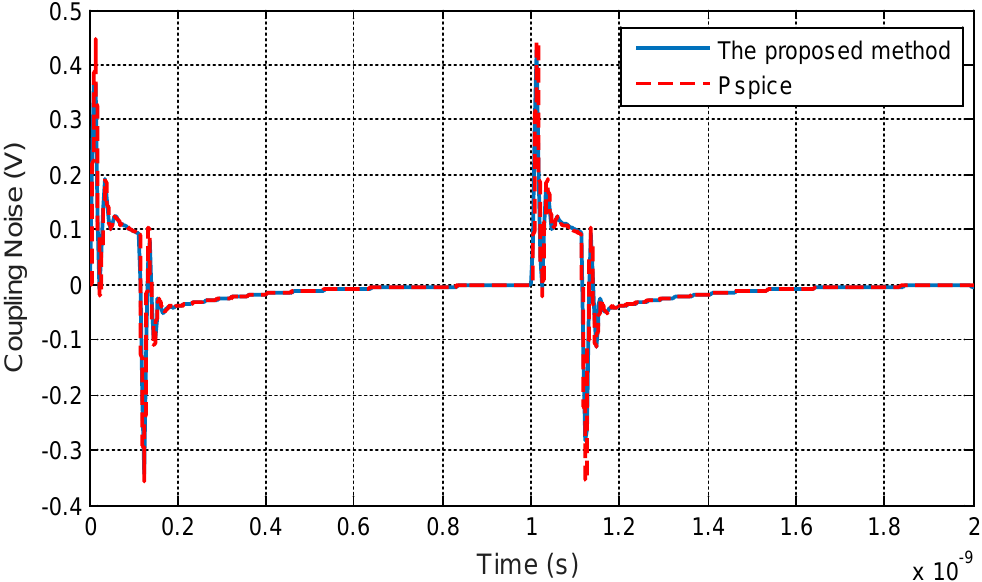
Figure 14. The proposed method and Pspice simulation of the TSV–TSV coupling noise with uncoupled RDLs ( l RDL = 500 µm) at port 4.